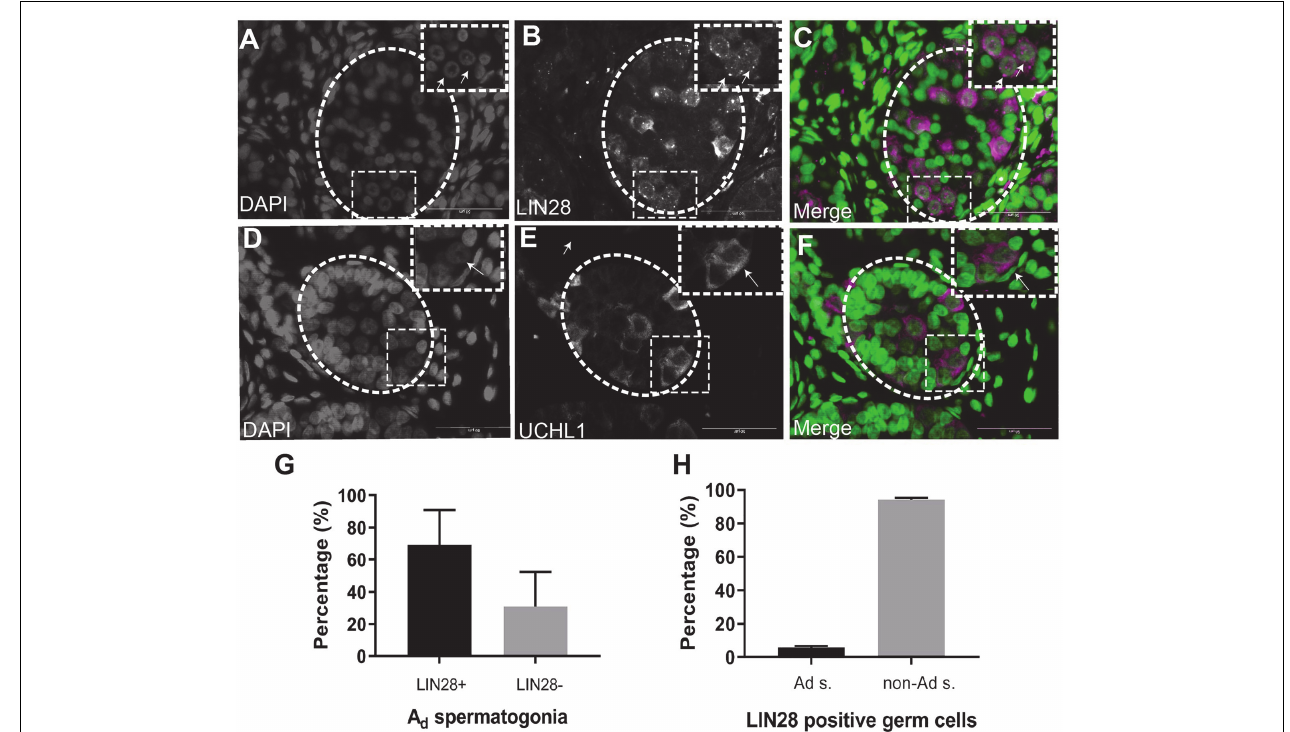
FIGURE 2 | Immunofluorescence staining analysis of germ cells in the undescended testis. (A) , DAPI. (B) , LIN28. (C) , Merge (DAPI in green and LIN28+ in magenta). LIN28 positive signals are present in germ cells with rarefaction zone in the nuclei. Dash lines represent seminiferous tubules. Arrows showing the rarefaction zone in the germ cell nuclei. (D) , DAPI. (E) , UCHL1, (F) , Merge (DAPI in green and UCHL1+ in magenta). Dash lines represent seminiferous tubules. Arrows showing the rarefaction zone in the germ cell nuclei. Scale bar: 50 µ m; (G) , Quantification of the percentage of LIN28 positive A d spermatogonia (A d s.) in total A d spermatogonia. (H) , The percentage of A d spermatogonia in total LIN28 positive germ cells in the undescended testis.